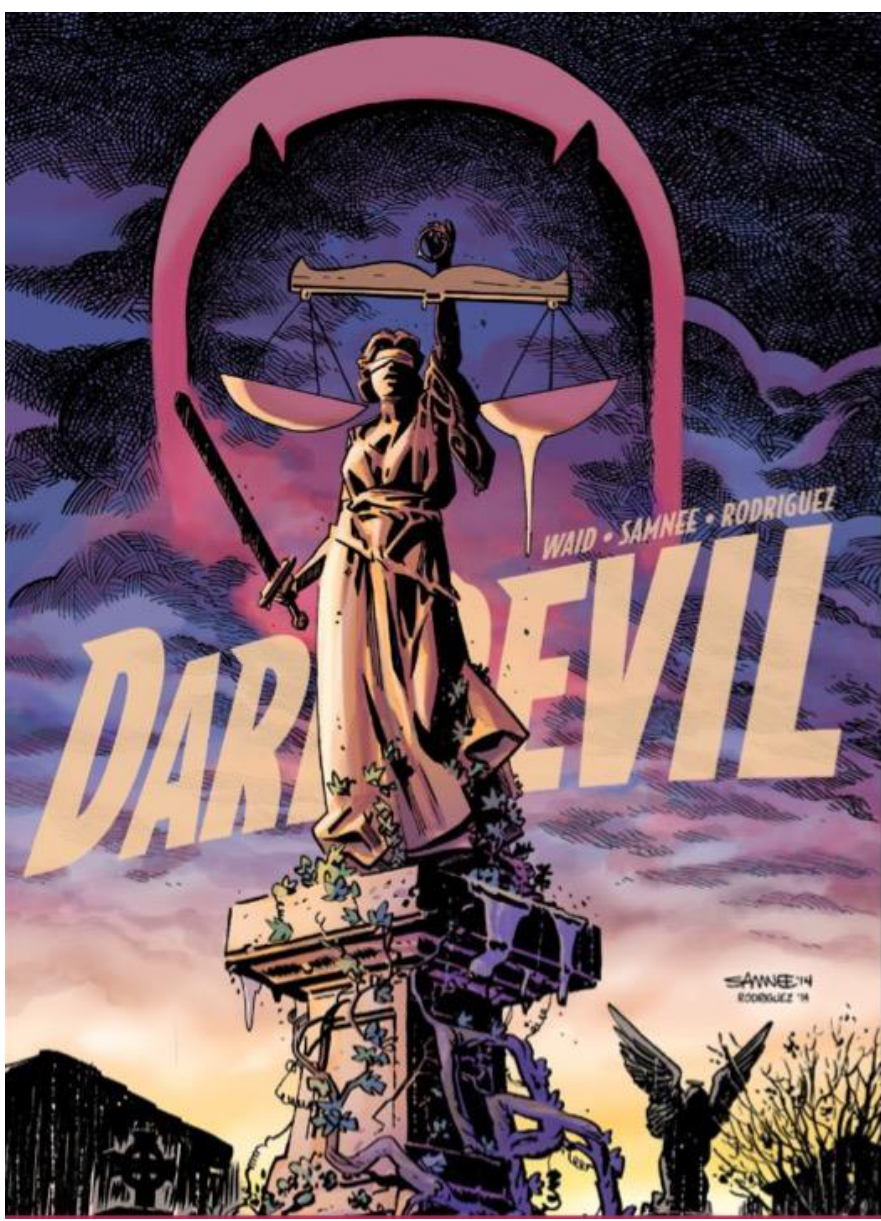
Figure 2. Cover from Waid Daredevil Vol. 1: Devil at Bay #3, 2014. Image Credit: Chris Samnee and Javier Rodiguez © 2014 Marvel Characters,